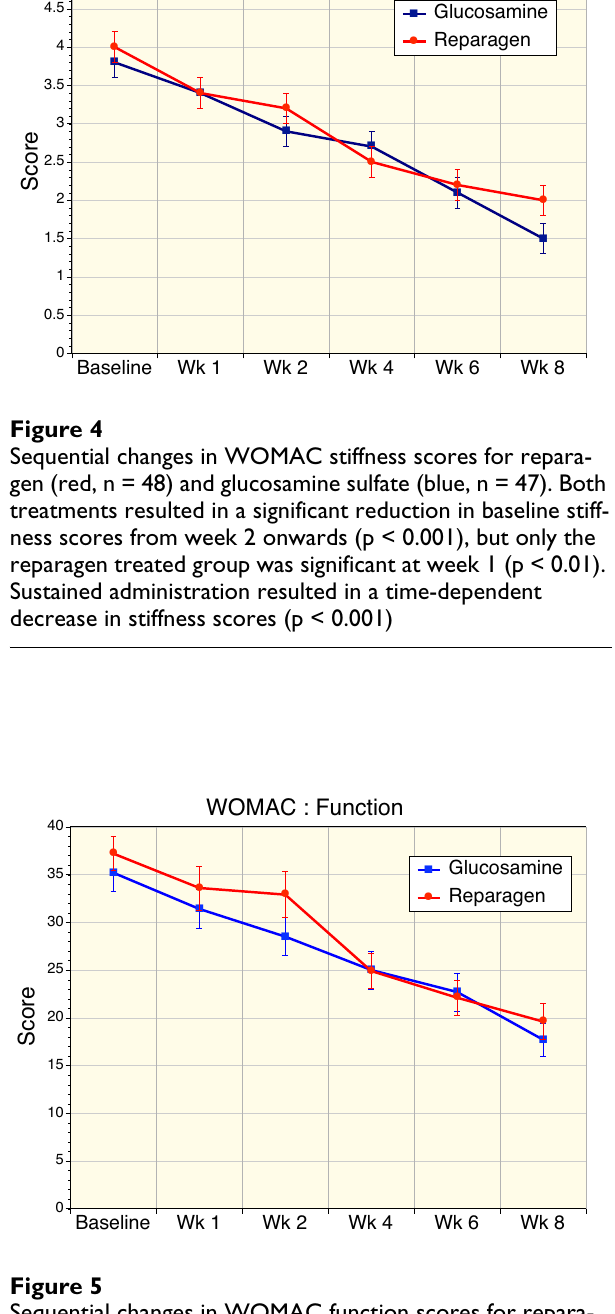
Figure 7 Sequential changes in VAS pain scores for reparagen (red, n = 38) and glucosamine sulfate (blue, n = 41). Both treatments resulted in a significant reduction in baseline VAS pain scores within one week (p < 0.01), with further reductions with sus- tained administration (p < 0.001).